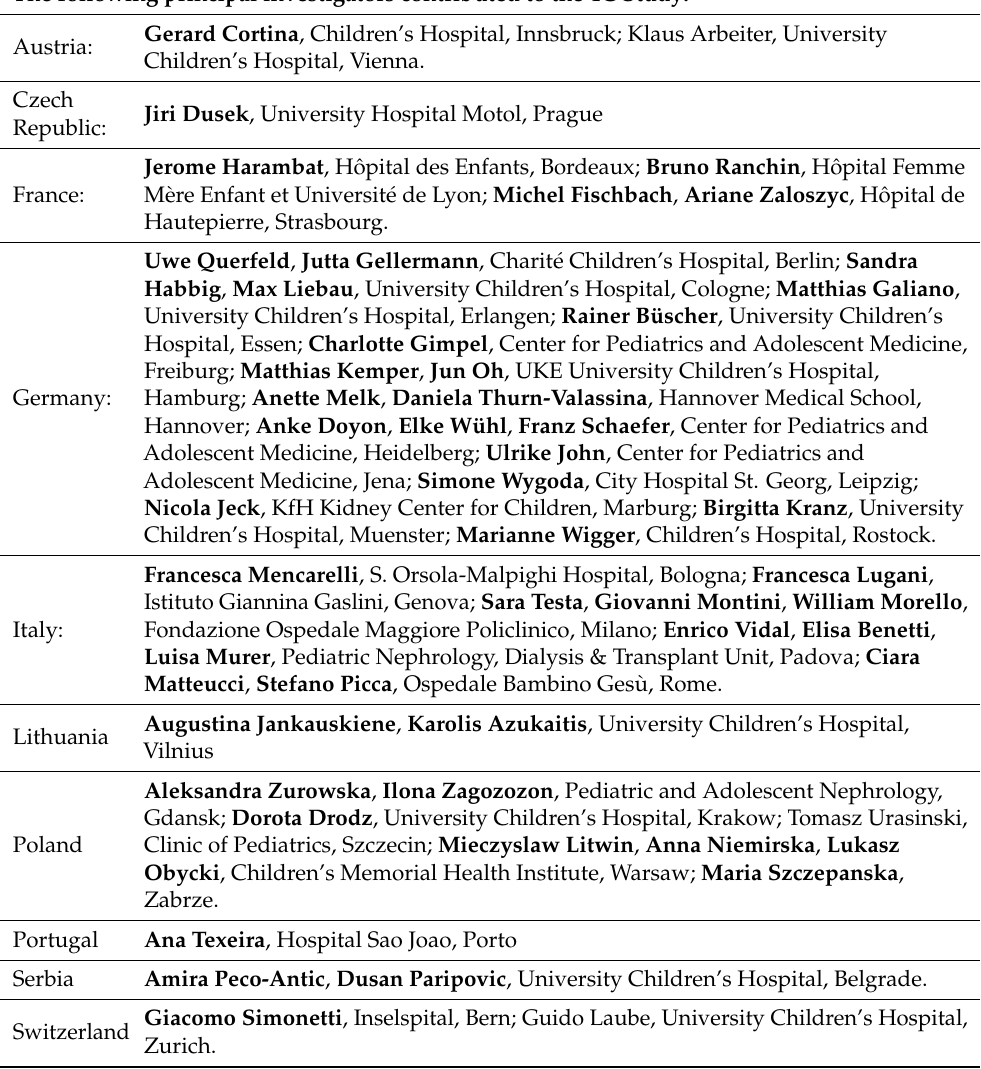
Table A1. List of investigators contributed to the 4C Study (including the institutions, collaborators names in